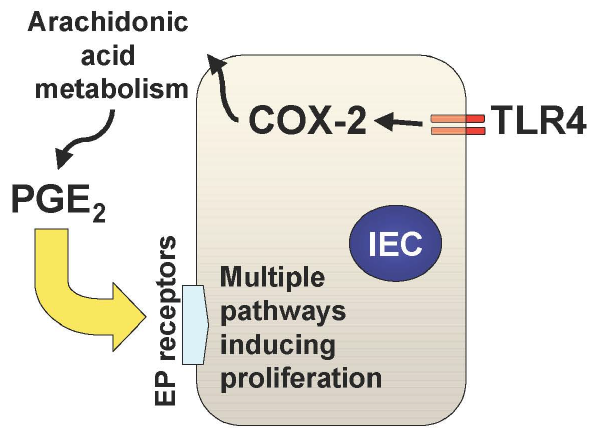
Figure 1. The TLR4-COX-2-PGE axis. In the setting of intestinal inflammation, epithelial 2 TLR4 is up-regulated. TLR4 signaling induces and stabilizes COX-2. COX-2 acts on arachidonic acid to generate PGE through a series of metabolic cascades. PGE 2 its receptors (EP receptors), can activate downstream signaling molecules that are associated with proliferation in intestinal epithelial cells.